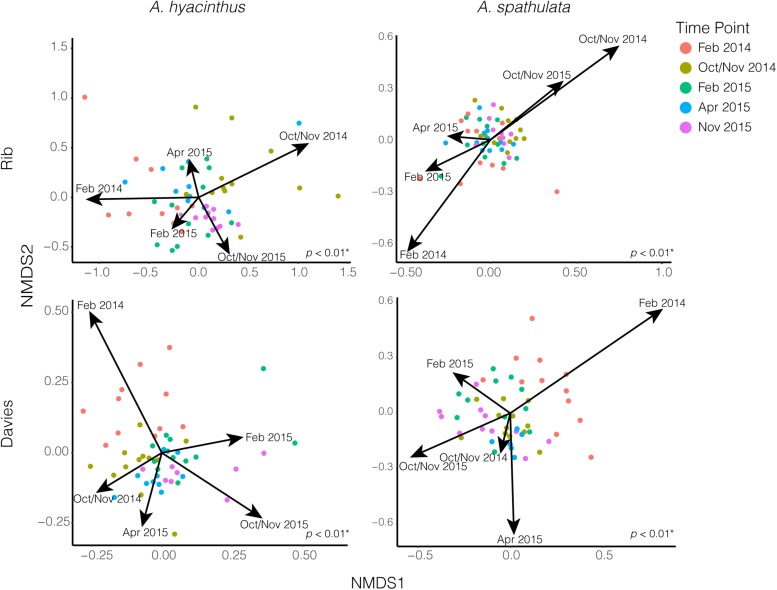
NMDS plots of bacterial communities for both A. hyacinthus and A. spathulata at Rib and Davies reef. Arrows representing time point were fit and scaled by constrained correspondence analysis (CCA). p-values in the lower right-hand corner of each nMDS plot represent PERMANOVA results.